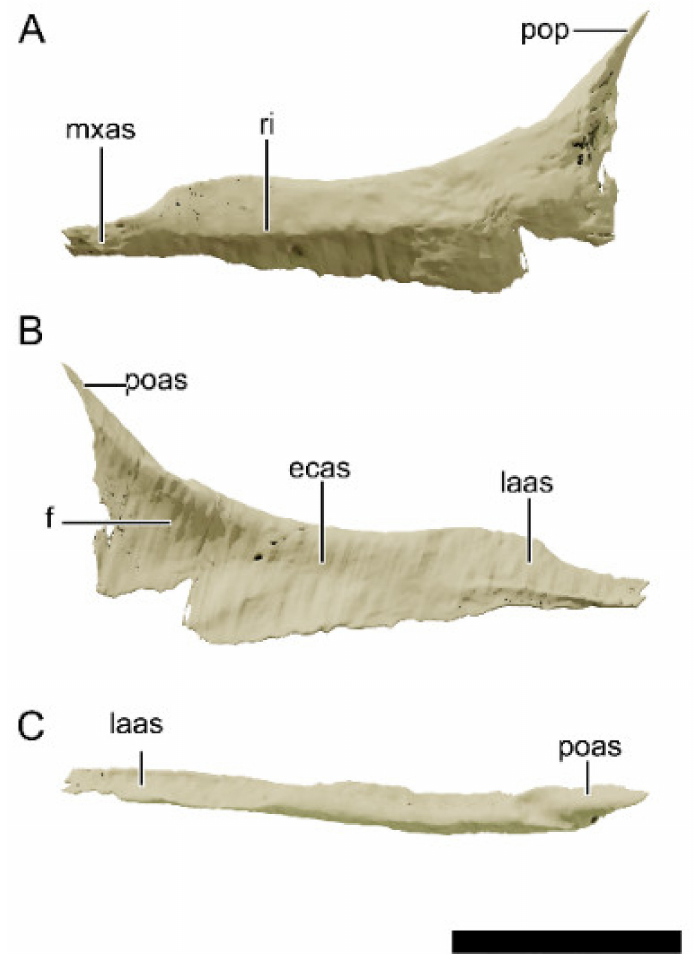
Figure 17. Digital reconstruction of the left jugal of NHMD 164758. ( A ) Lateral view. ( B ) Medial view. ( C ) Dorsal view. Abbreviations: ecas, articular surface for the ectopterygoid; f, fossa; laas, articular surface for the lacrimal; mxas, articular surface for the maxilla; poas, articular surface for the postorbital; pop, postorbital process; ri, ridge. Scale bar = 20